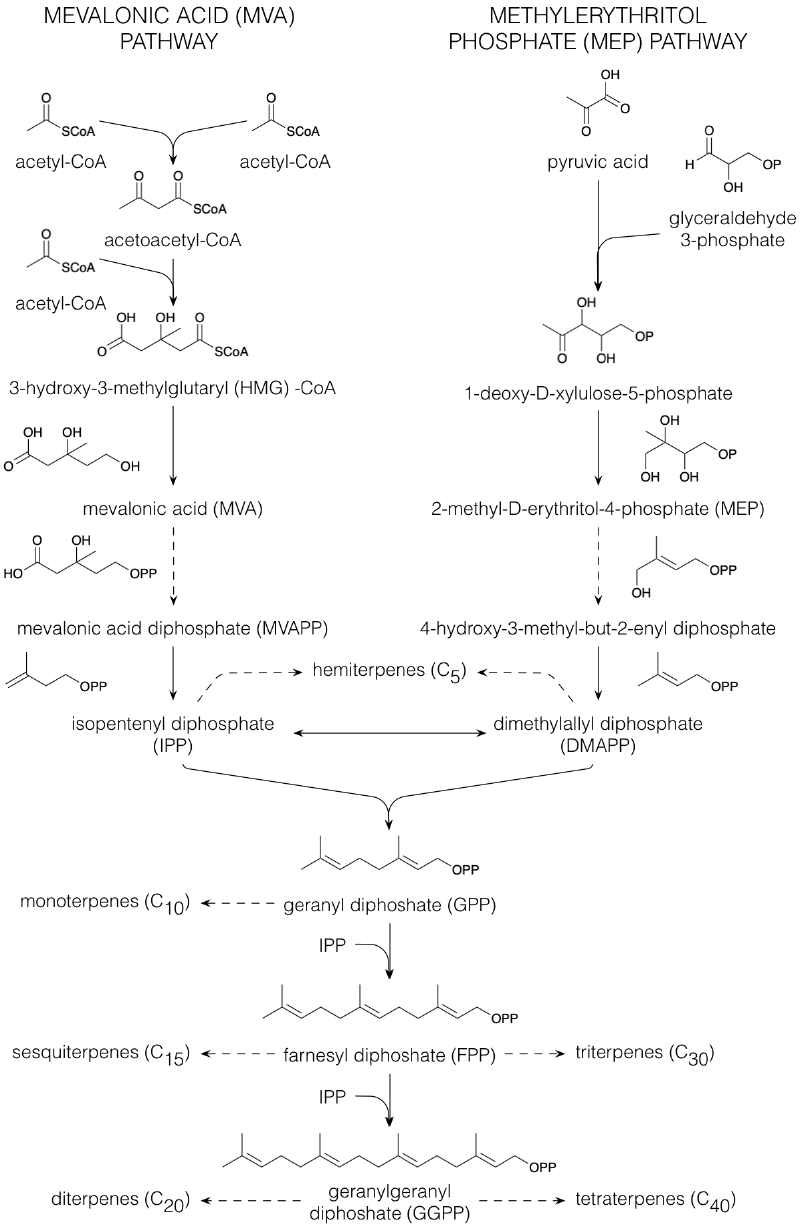
Figure 2. Biosynthesis of terpenoids. Dashed arrows indicate multiple conversions. In plants, terpenoids play a role in plant growth and development as photosynthetic pigments (e.g., carotenoids, C 40 ), electron-carriers (e.g., ubiquinone, C 40 ), regulators of growth and development (e.g., gibberellins, C 20 ) or as part of membrane structures (e.g., phytosterols, C 30 ) [35,36]. In addition, volatile, low-molecular weight terpenoids (C 5 -C 10 ) are involved in the protection of plants against biotic (e.g., microbial pathogens) and